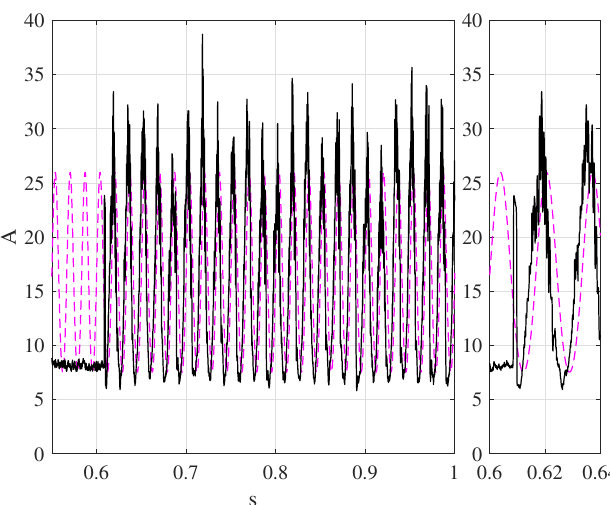
Figure 6. Output tracking of the inductor current with α = 377 (60 Hz). Reference signal in dashed line, and inductor current in solid line.